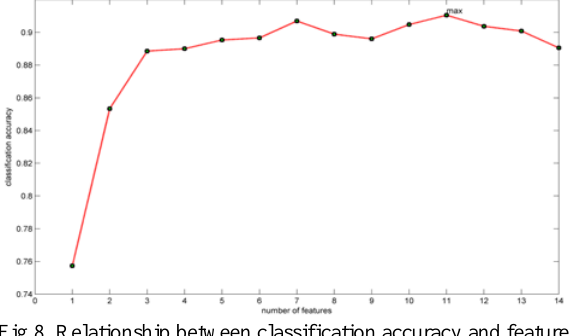
Fig.8. Relationship between classification accuracy and feature number